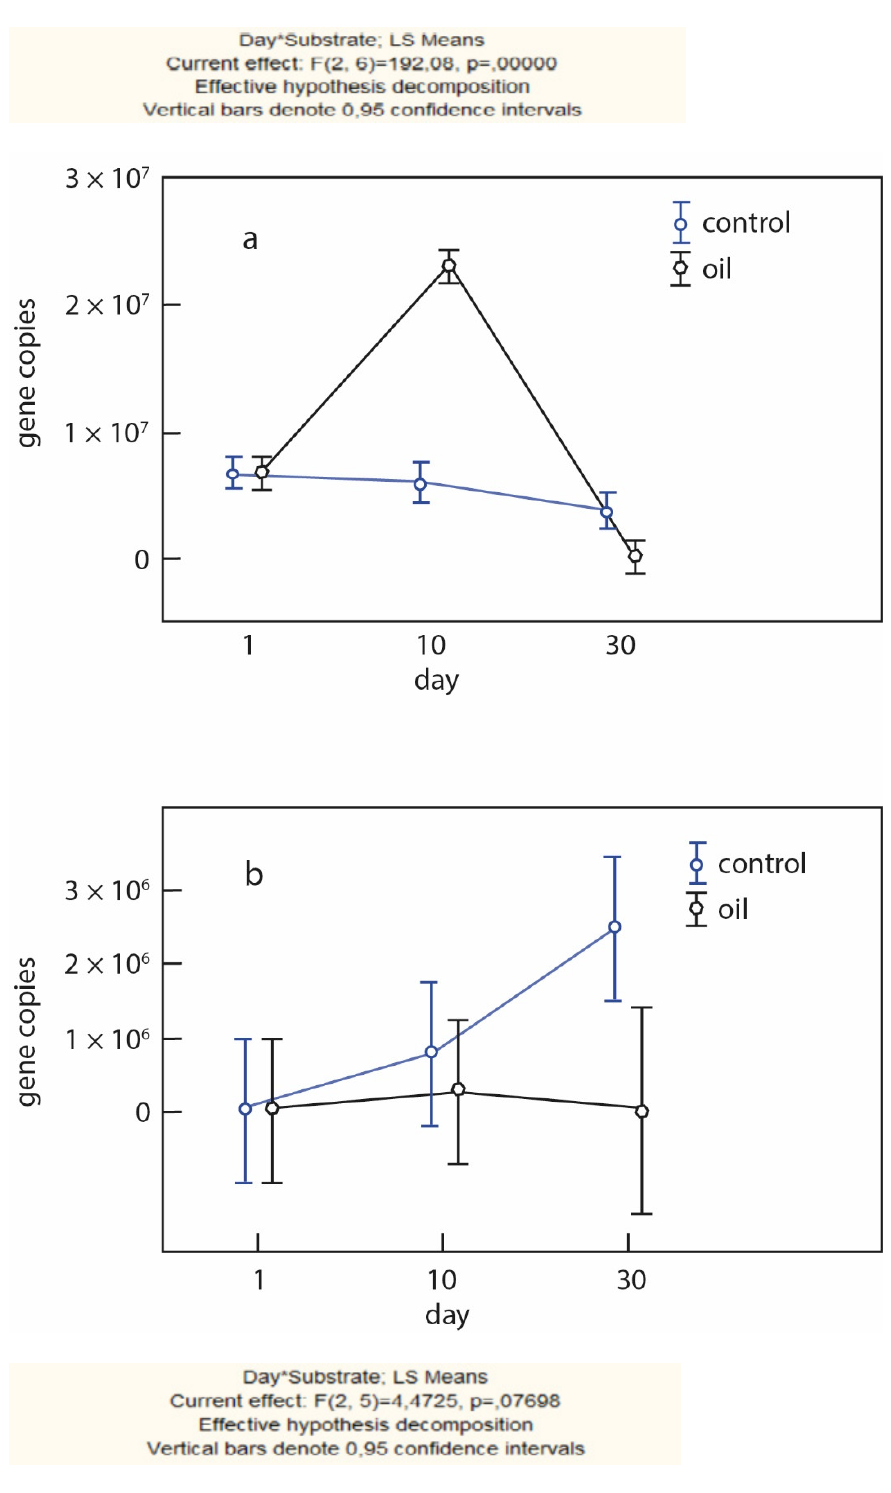
Figure 8. Dynamics of functional amoA genes in volcanic soils (modern horizon): ( a )—bacteria; ( b )— archaea.